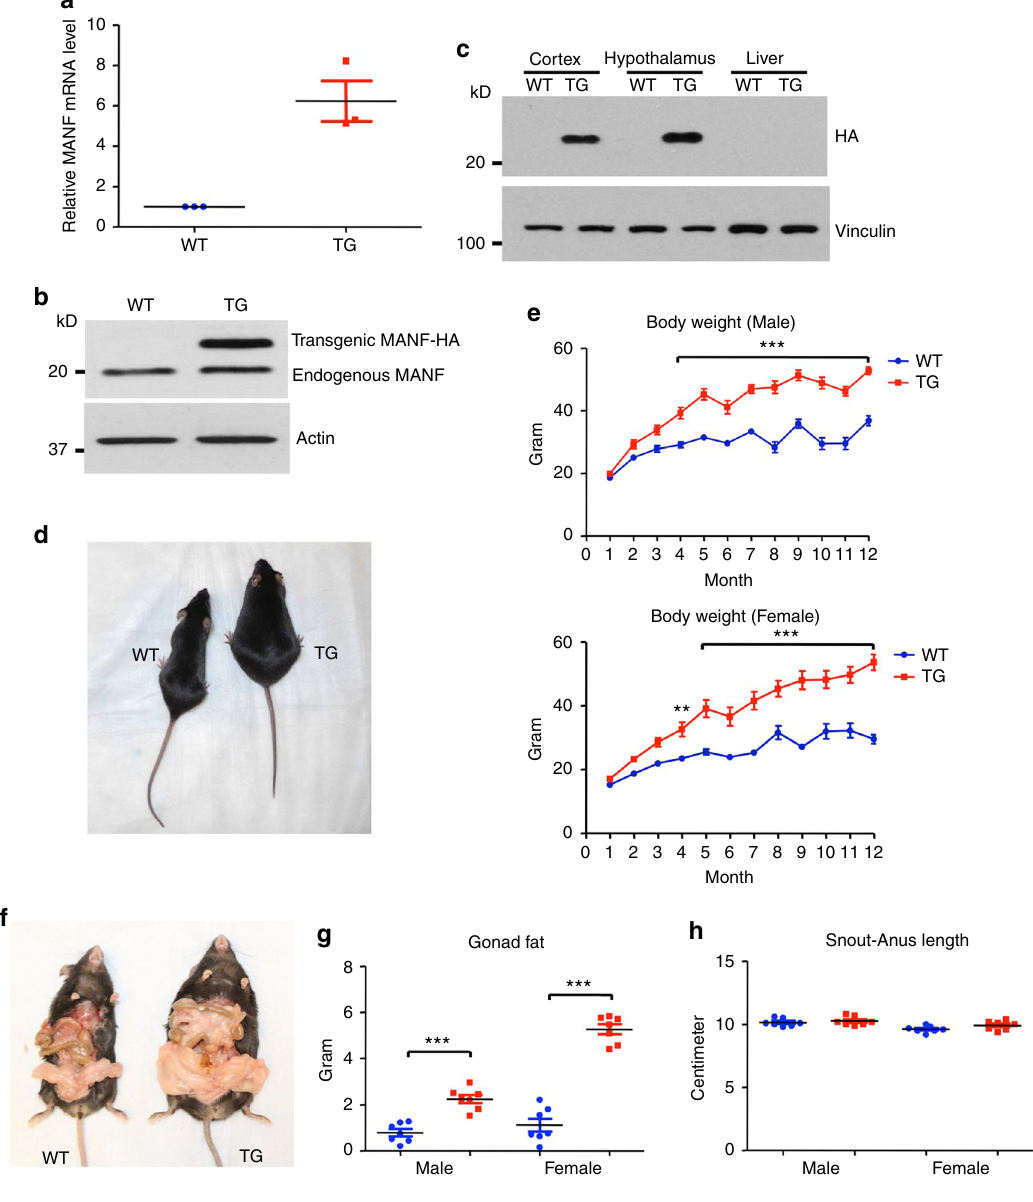
Fig. 2 Characterization of MANF transgenic mouse model. a qRT-PCR result compared the levels of MANF mRNA in the brain of wild type (WT) and MANF transgenic (TG) mice ( n = 3, 2-tailed student t test, t = 5.224, P = 0.0347). b A single western blotting image showing endogenous and transgenic MANF expression in the brain of WT and TG mice. c A single western blotting image with an HA antibody con fi rmed that transgenic MANF is highly expressed in the cortex and hypothalamus of TG mice. d A single image of 4-month old WT and TG mouse. e Body weights of male and female mice were measured monthly from 1-month to 12-months of age (** P < 0.01, *** P < 0.001, n = 8 – 10, two-way ANOVA with Bonferroni post-tests, Male, F = 401.4, P < 0.0001; Female, F = 292.5, P < 0.0001). f A single image of 4-month-old WT and TG mice showing fat deposition. g Gonad fat of 4-month old male and female mice were weighed (*** P < 0.001, n = 7; 2-tailed student t test, Male, t = 6.17, P < 0.0001; Female, t = 11.53, P < 0.0001). h Snout-anus lengths of 4-month old male and female mice were measured n = 7, 2-tailed student t test, Male, t = 0.651, P = 0.5273; Female, t = 1.807, P = 0.0958). Data